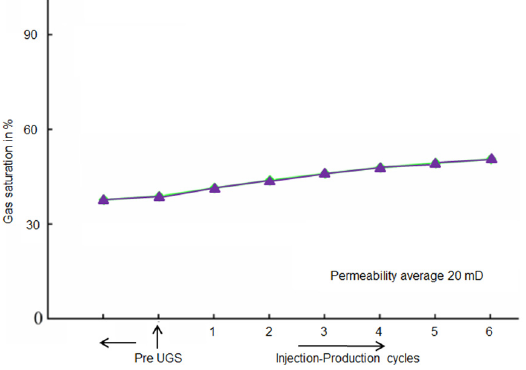
Figure 16. Gas saturation (%) during injection-production cycles.